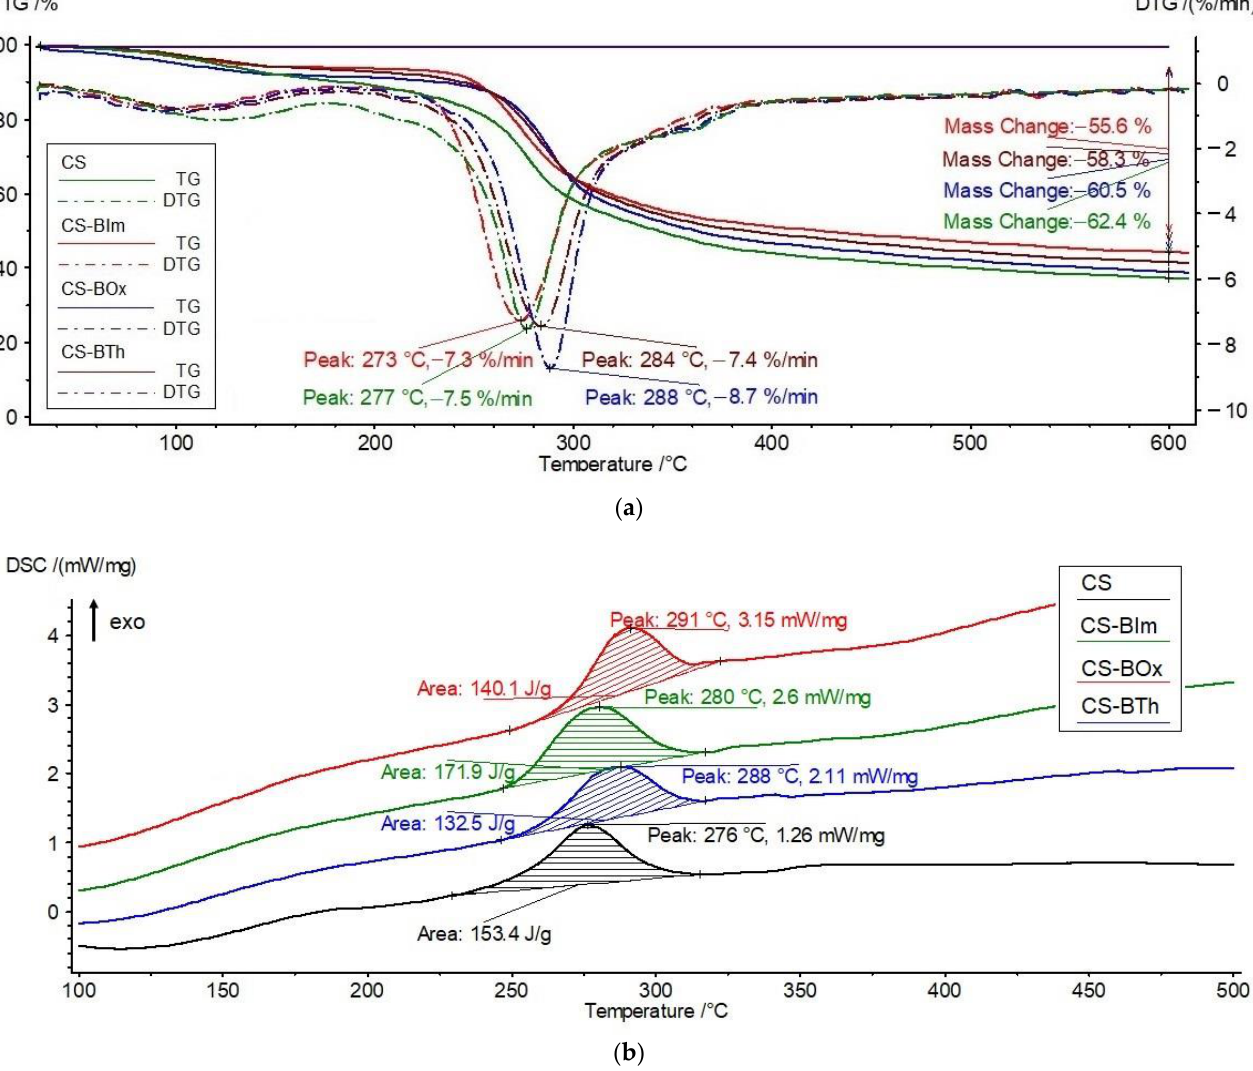
Figure 4. TG/DTG ( a ) and DSC ( b ) curves of CS, CS-BIm, CS-BOx, and CS-BTh (unirradiated).